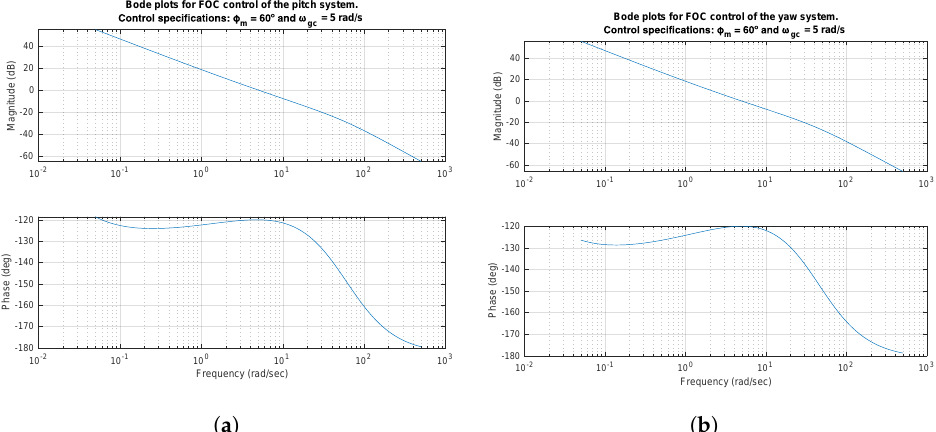
Figure 12. Bode plots of the open loop systems with the resulting FOPI controllers. Control specifica- tions: φ m = 60 ◦ and ω gc = 5 rad/s. ( a ) Bode plots of the open loop system with the FOPI controller corresponding to the pitch system. ( b ) Bode plots of the open loop system with the FOPI controller corresponding to the yaw